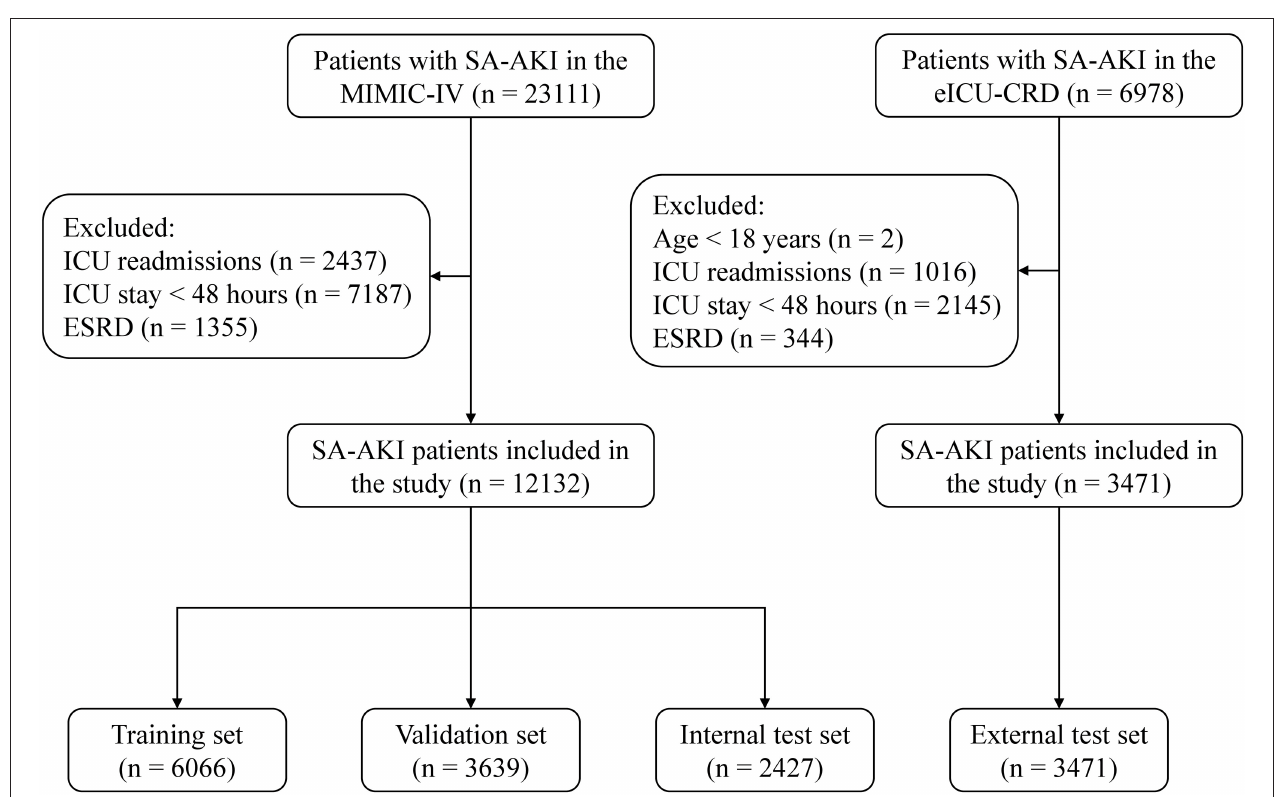
FIGURE 1 | Study flow diagram. SA-AKI, sepsis-associated acute kidney injury; ICU, intensive care unit; ESRD, end-stage renal disease.